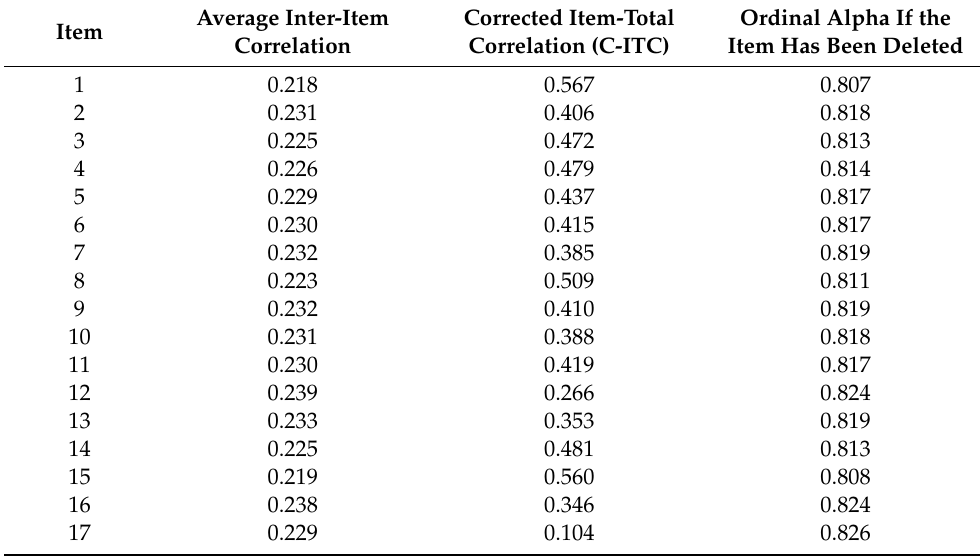
Table 6. Internal consistency results for the Breadcrumbing A ff ective-Sexual Relationships (BREAD-ASR)